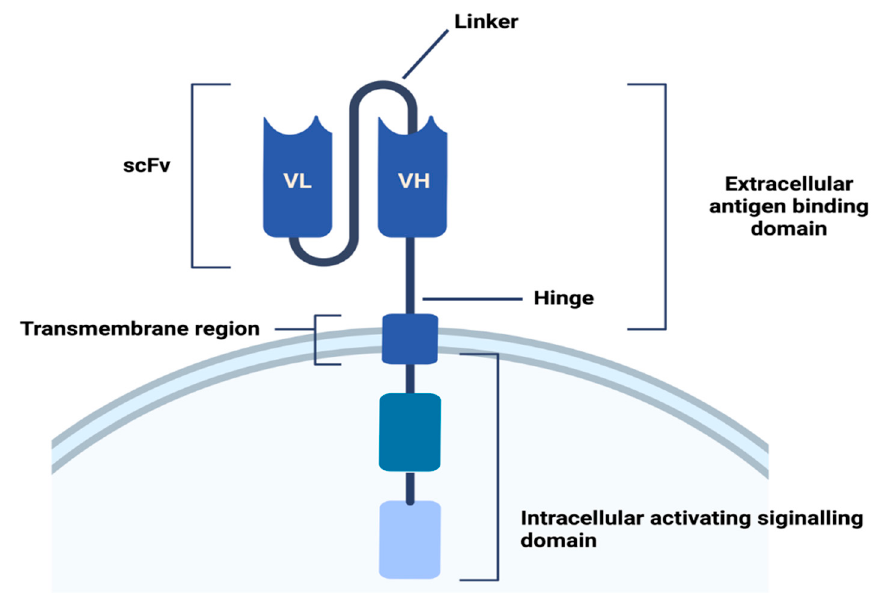
Figure 1. Structure of CAR receptor [16].